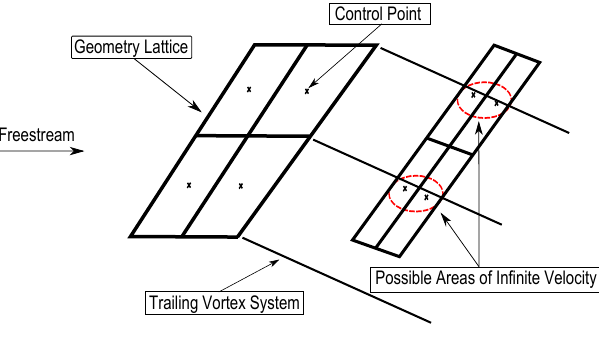
Figure 2. A wing and trailing-edge flap system modelled using a traditional vortex lattice method